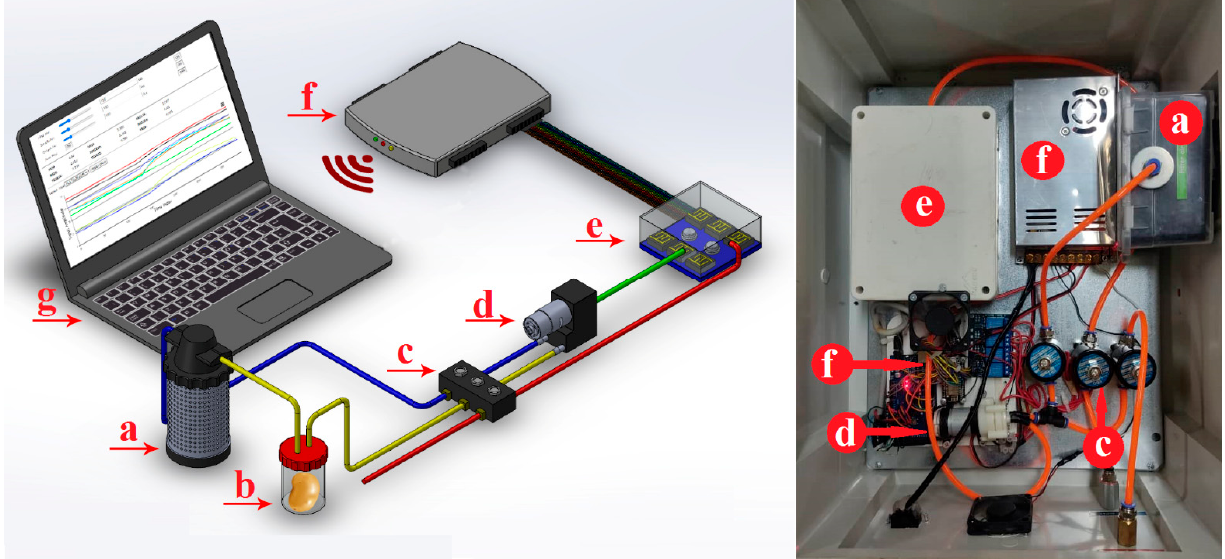
Figure 1. Schematic of an artificial olfactory (e-nose) system, the components of this system consist of the following parts (listed in order and direction of airflow as follows). ( a ) Air filter (activated charcoal to remove ambient-air VOC hydrocarbons), ( b ) sample headspace chamber, ( c ) solenoid air valves, ( d ) diaphragm pump, ( e ) e-nose sensor array chamber, ( f ) data acquisition recorder and wireless transmission card, and ( g ) personal computer (PC). Adapted from ref. [22].